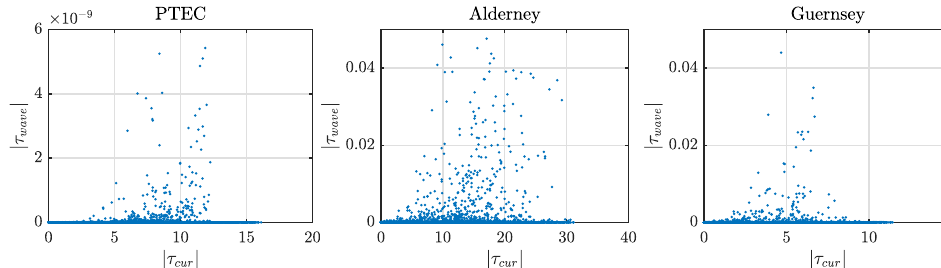
Figure 11. Scatter plots of wave bed shear stress against current bed shear